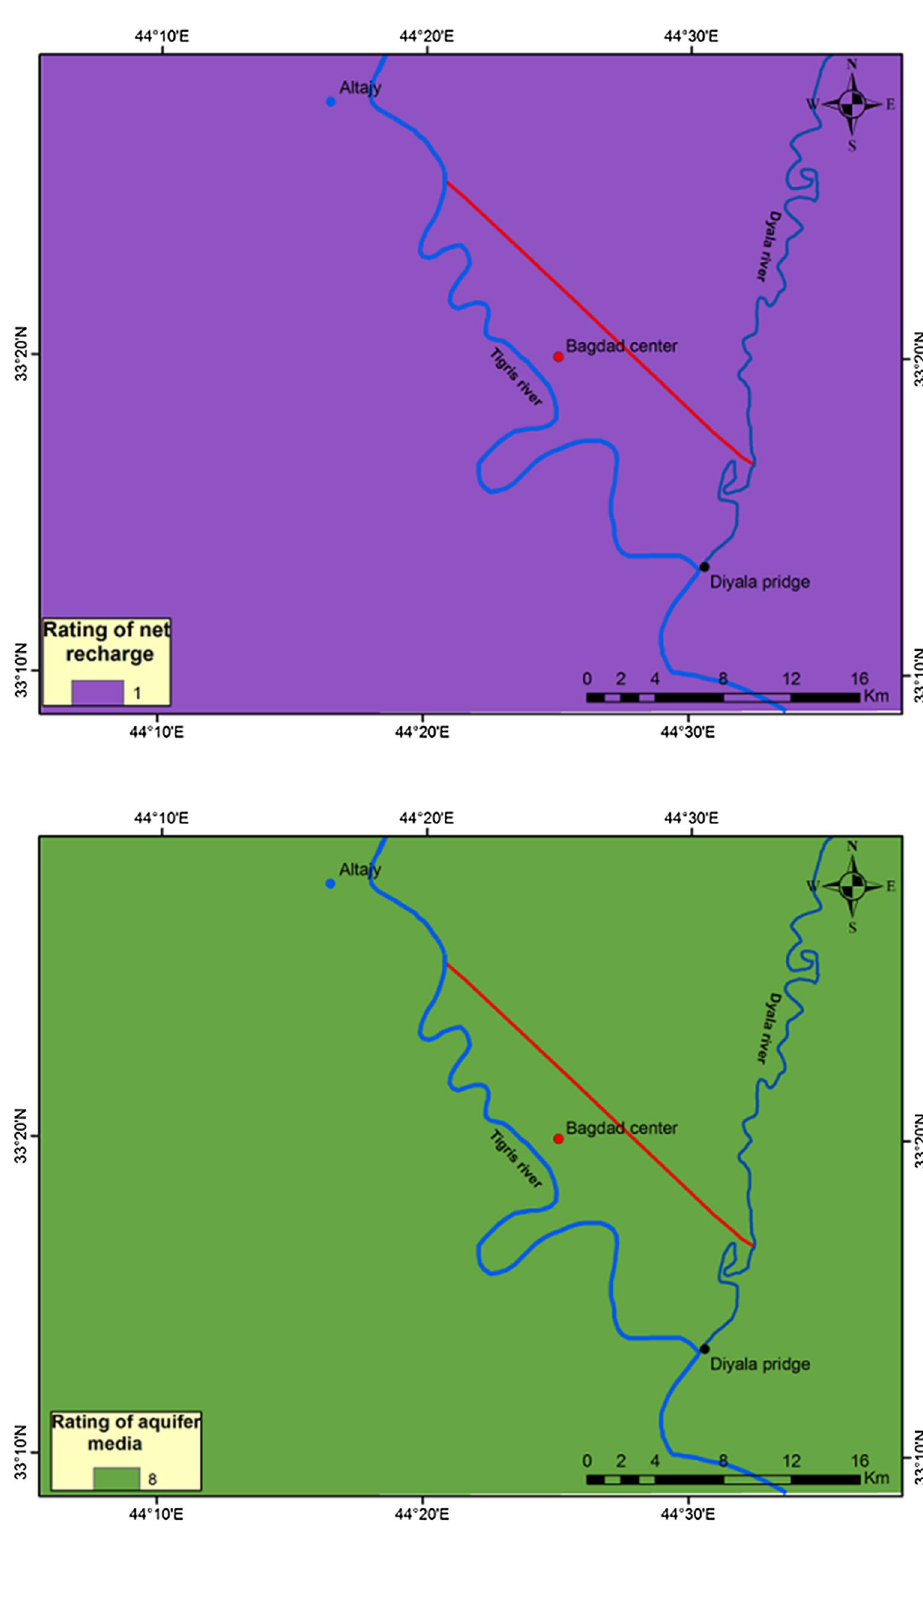
Fig. 6 Rating of net recharge map of the study area